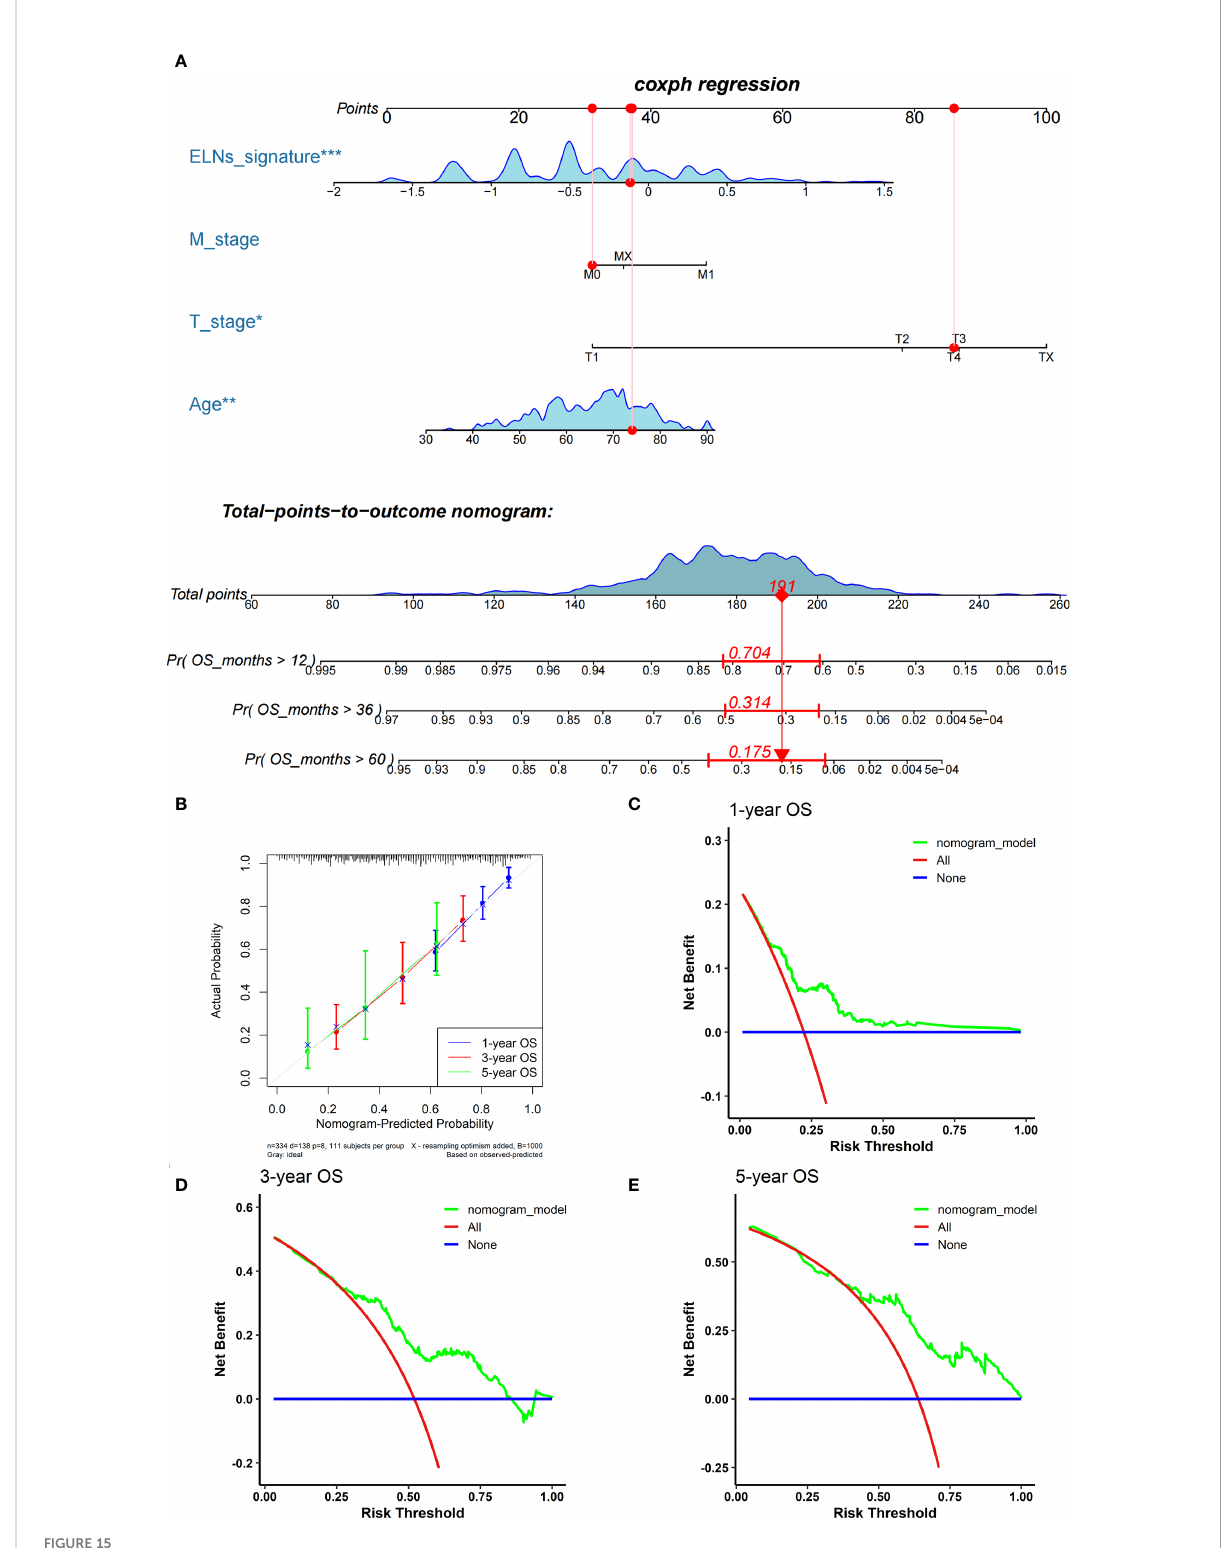
FIGURE 15 Establishment and assessment of the nomogram. (A) The nomogram plot was built based on the ELNs signature, age, M stage, and T stage. (B) The calibration curves showed that the predicted OS of the nomogram is highly concordant with the actual OS. (C – E) DCAs of the nomogram for 1-, 3-, and 5-year OS in the TCGA cohort. OS, overall survival; DCA, decision curve analysis. *p < 0.05; **p < 0.01; ***p <